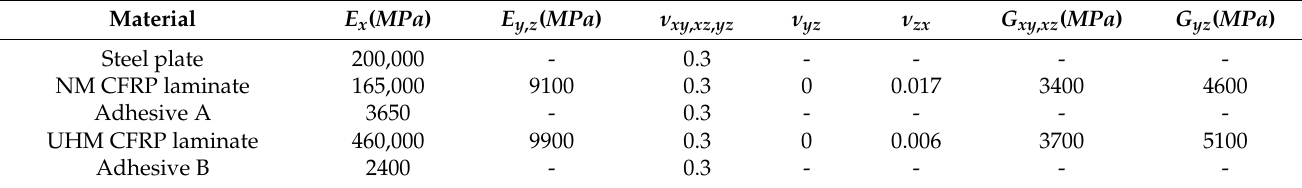
Table 3. Input mechanical properties in finite element model (FEM) for isotropic materials.